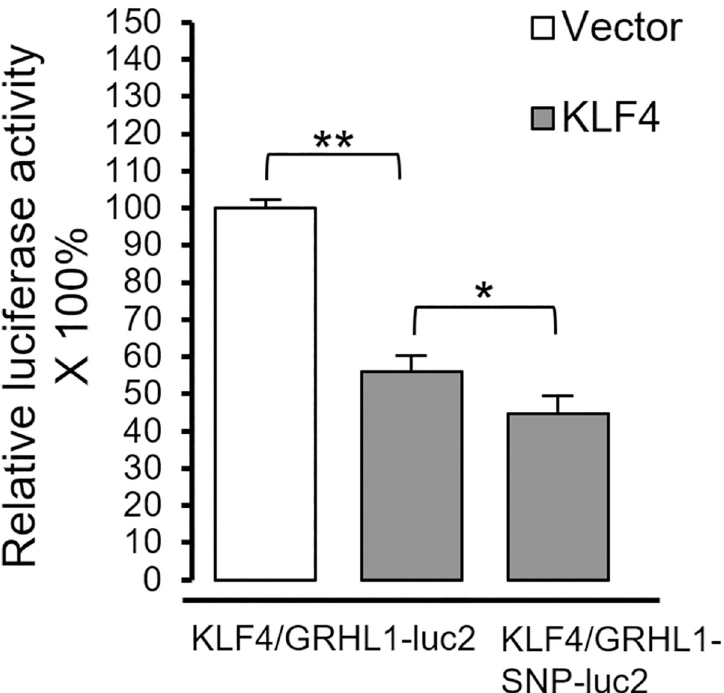
Fig 7. Impact of the presence of the minor frequency allele of SNP rs115898376 in the promoter of GRHL1 gene on KLF4 binding. HEK293 cells were transfected with pcDNA3.1-KLF4 or pcDNA3.1-empty plasmid, pGL3-promoter vector containing the luciferase gene under the control of the fragment of the GRHL1 regulatory sequence with either the major or the minor frequency allele of SNP rs115898376 (named KLF4/GRHL-luc2 and KLF4/GRHL1-SNP-luc2), and pRL-CMV Renilla luciferase control reporter vector. The presence of the minor frequency allele of SNP rs115898376 in the promoter of GRHL1 gene alters the functioning of the KLF4 binding